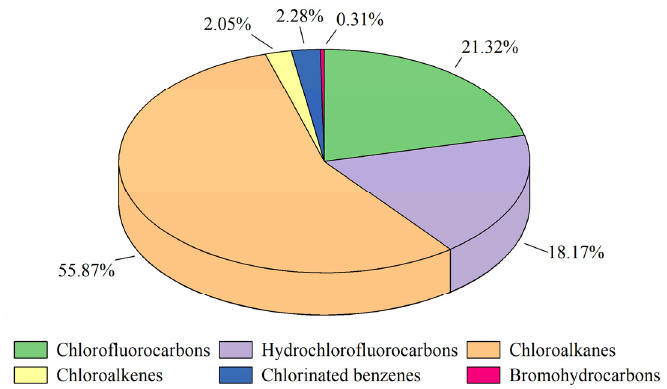
Figure 2. Composition of atmospheric volatile halogenated hydrocarbons at the study site (by category).